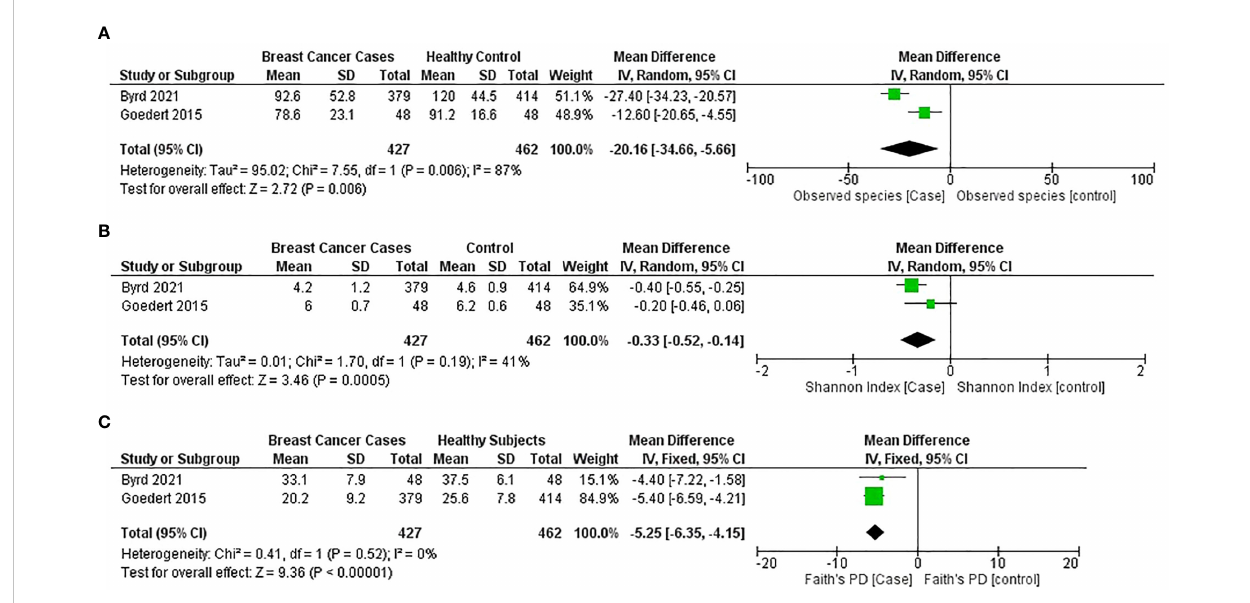
FIGURE 5 Meta-analysis forest plot representing the risk of breast cancer by different microbial pro fi ling indexes like: (A) observed species; (B) Shannon index; and (C) faith ’ s